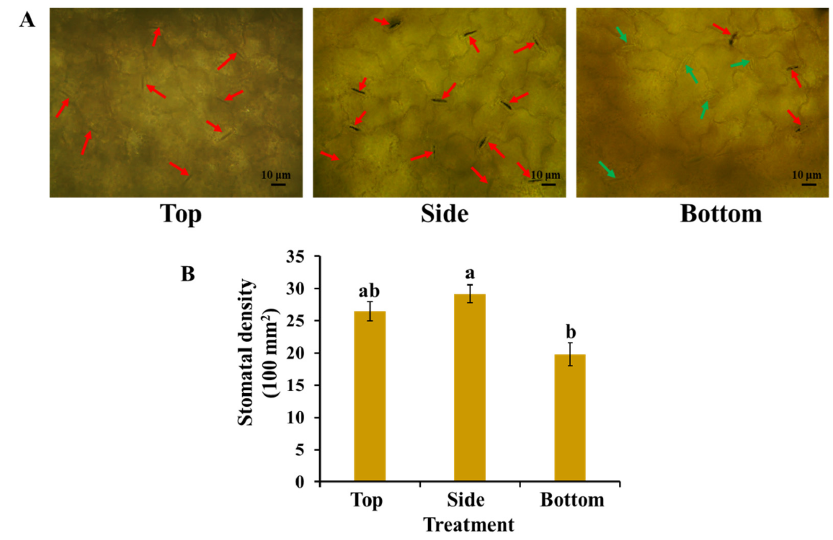
Figure 4. Stomatal micrographs ( A ) (10 × ) and changes in the stomatal density ( B ) of strawberry ‘Sulhyang’ plants as affected by the lighting direction after 45 days of cultivation. Vertical bars indicate the means ± standard error ( n = 6). Different lowercase letters indicate significant separations within treatments by Duncan’s multiple range test at p ≤ 0.05. Bars indicate 10 µ m. Red arrows indicate opened stomatal pores, green arrows indicate closed stomatal pores.